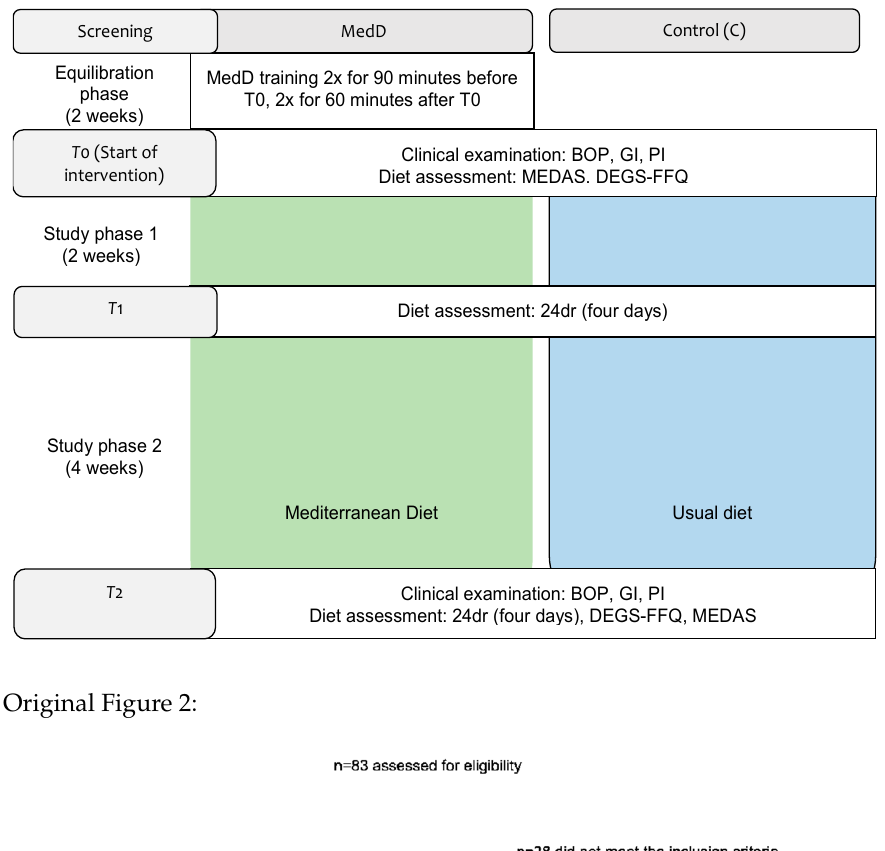
n=28 did not meet the inclusion criteria n=13 declined participation